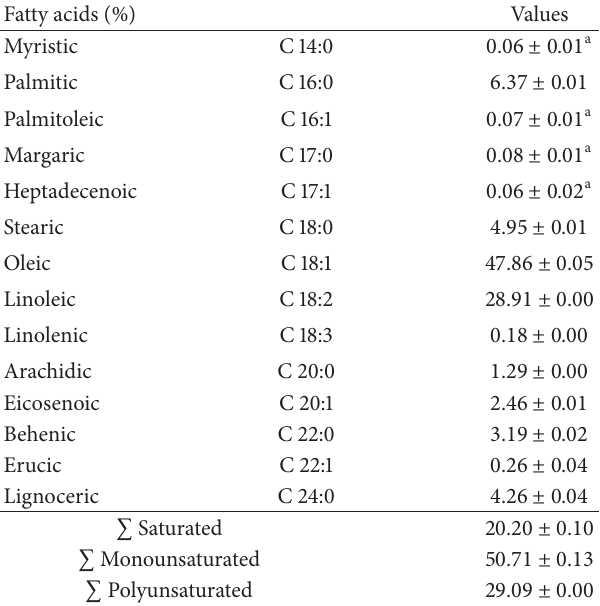
Table 1: Composition of fatty acids in the oil from Dipteryx alata Vogel oil. Values are expressed as a percentage in relation to total fatty acids